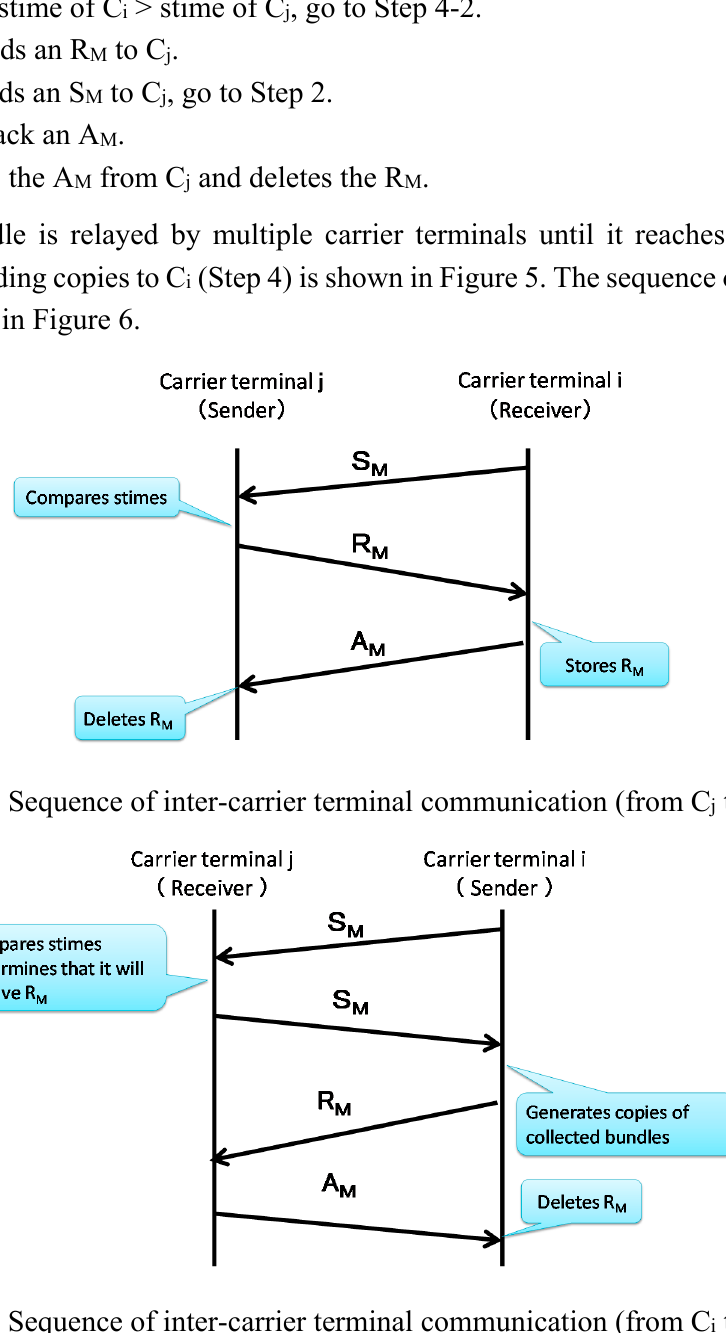
Figure 6. Sequence of inter-carrier terminal communication (from C i to C j